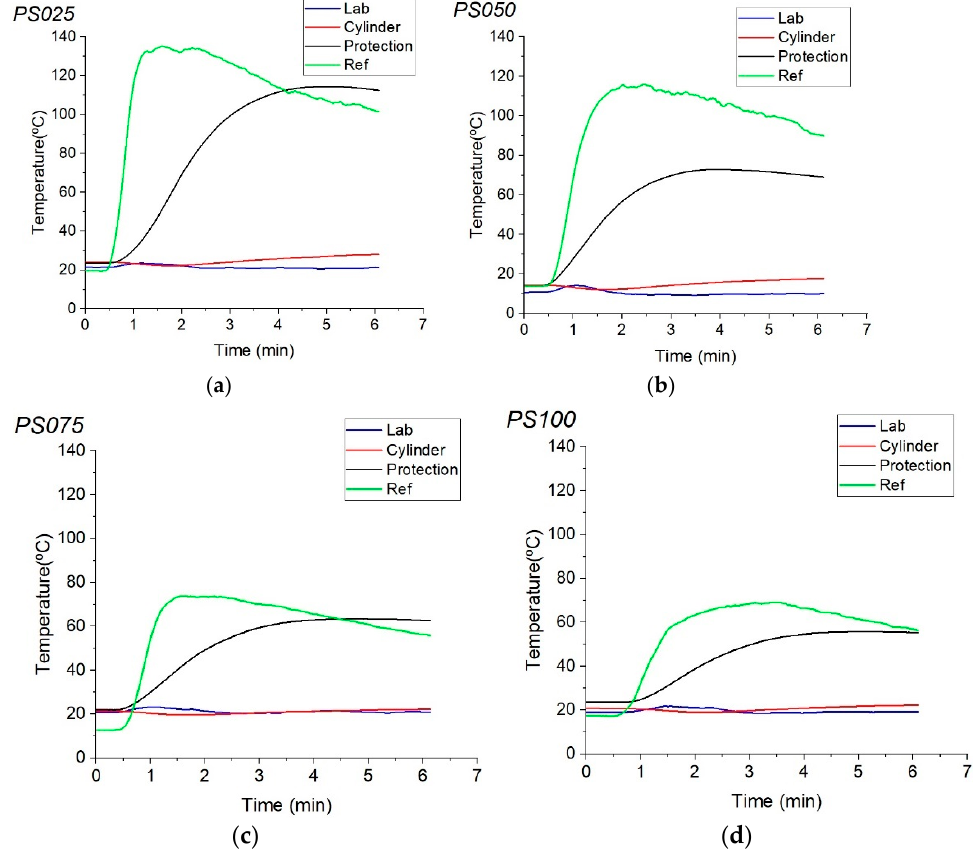
Figure 6. Temperature profile in the laboratory, on the protection, cylinder, and reference tests at ( a ) 0.25, ( b ) 0.50, ( c ) 0.75, and ( d ) 1 m from the basket fuel.